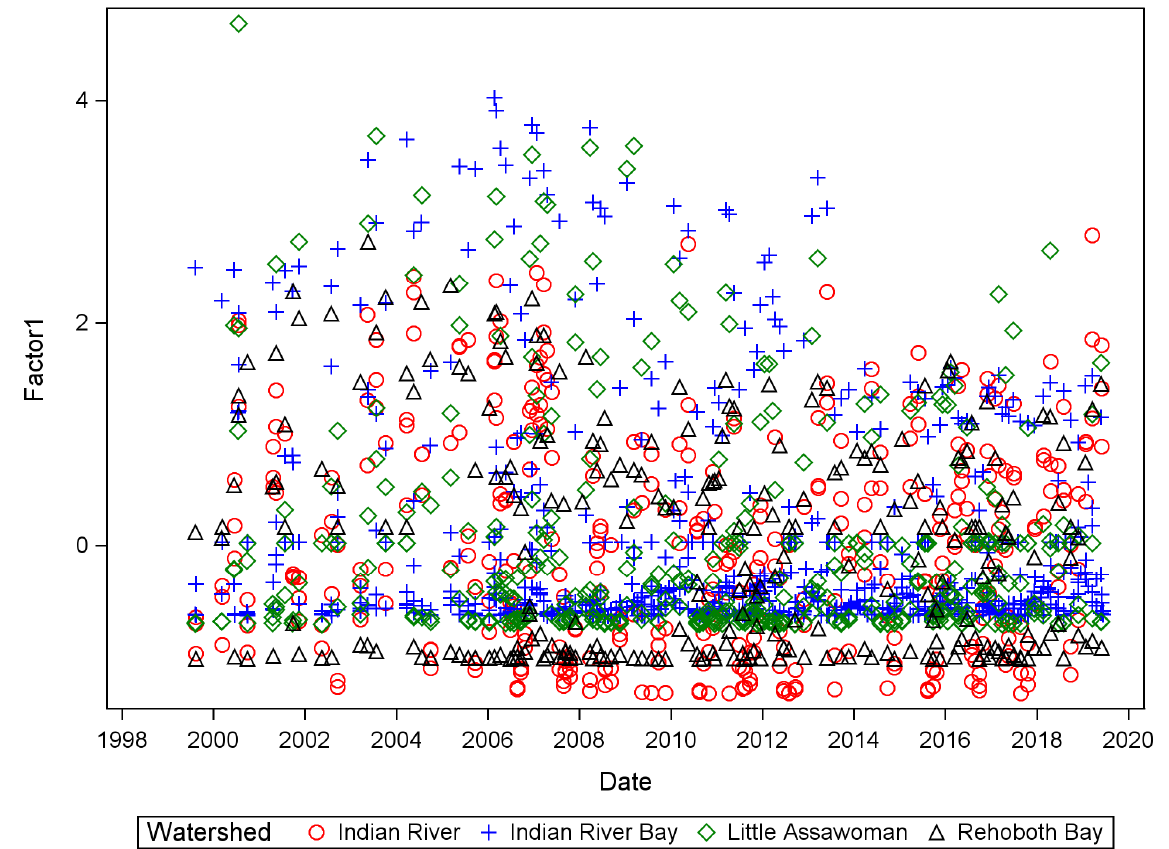
Figure 4. PC1, here represented as Factor 1, which is the freshwater inflow effect, of the dissolved nitrogen variables scores in the Inland Bays with respect to date. Table 4. Correlation between dissolved phosphorus (P-PO 4 ) and nitrite+nitrate (N-NO 2_3 ) with chlorophyll-a (chl-a) and total suspended solids. All values have p <